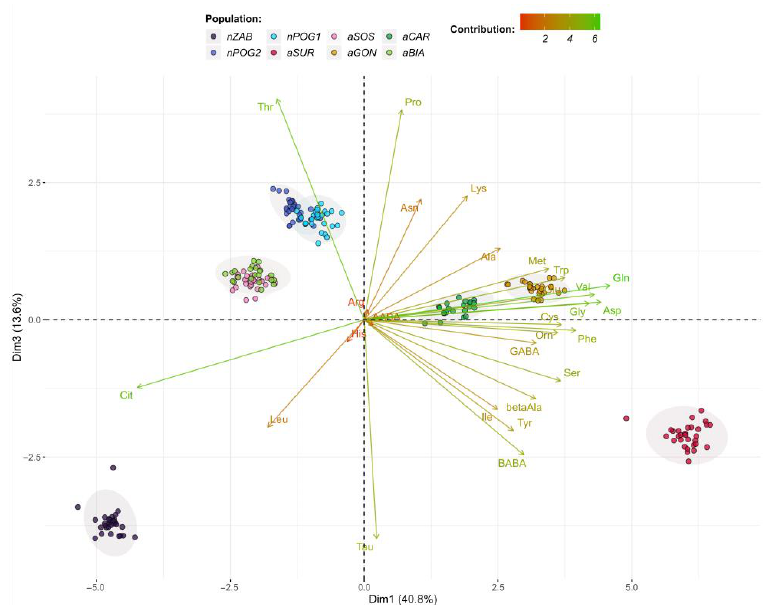
Figure 4. Biplot of amino acid profiles for the anthropogenic (aBIA, aCAR, aGON, aSOS, and aSUR) and natural (nPOG1, nPOG2, and nZAB) Epipactis helleborine populations showing the first two dimensions/factors (Dim1-2) of the PCA that together explain 66.9% of the variance. The biplot vectors indicate the strength and direction of factor loading for the first two factors. Individuals (populations) are color-coded by population. The ellipses around the individuals show an assumed 95% multivariate normal distribution.